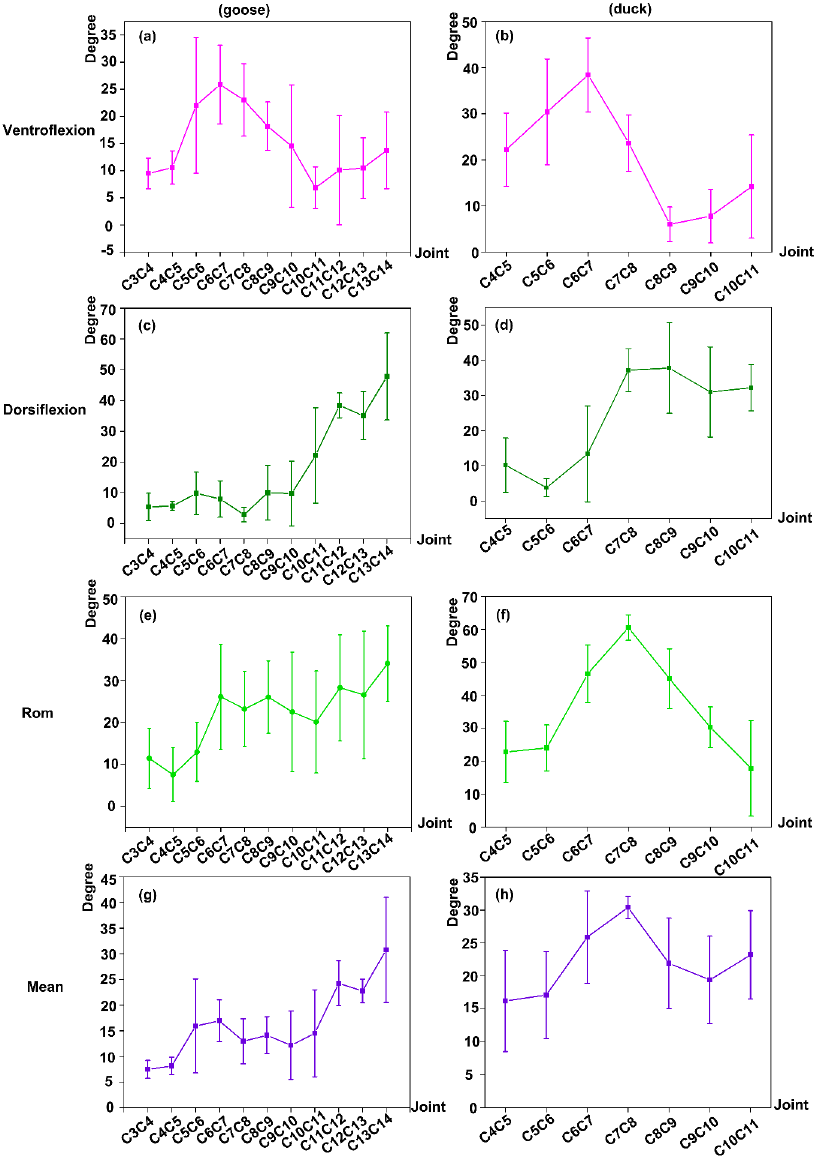
Figure 6. The RoM for goose and duck. ( a , b ) The measured maximum angle for adjacent vertebrae at the maximum ventroflexion posture. ( c , d ) The measured maximum angle for adjacent vertebrae at the maximum dorsiflexion posture. ( e , f ) The calculated RoM. ( g , h ) The mean-variance histogram of the absolute average value of ventroflexion and dorsiflexion movement. (Diagrams on the left are for geese, and diagrams on the right are for ducks).